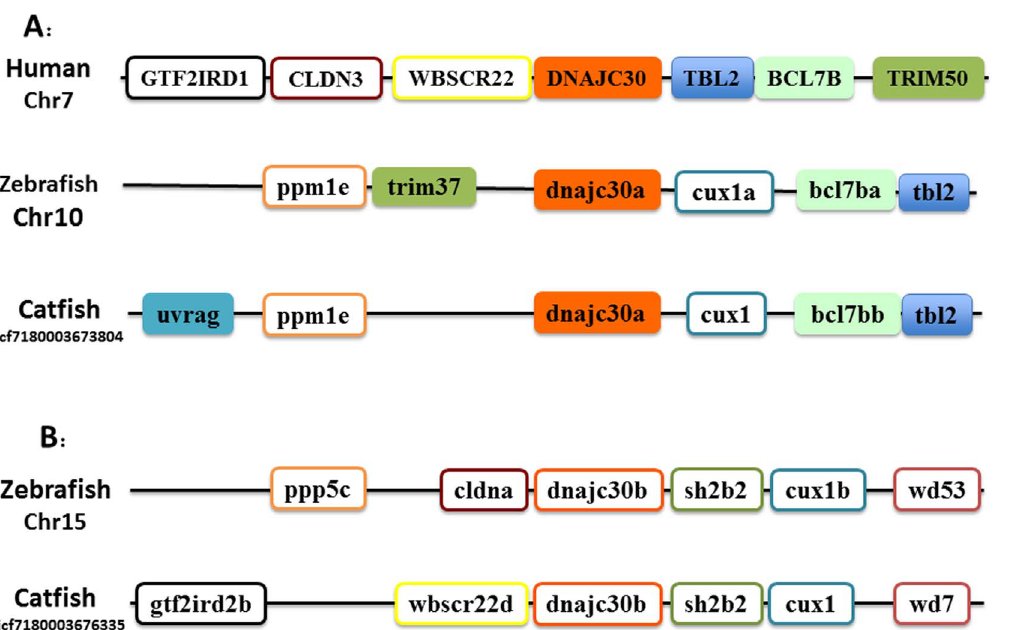
Fig. 4. Schematic presentation of the conserved synteny blocks neighboring DnaJc30a (A) and DnaJc30b gene (B). Note that in each case, the gene order and orientation was relatively conserved.Abbreviations: (A) GTF2IRD1, GTF2I repeat domain containing 1; CLDN3, claudin 3; WBSCR22, Williams Beuren syndrome chromosome region 22; DnaJc30, DnaJ (Hsp40) homolog, subfamily C, member 30; TBL2, transducin (beta)-like 2; BCL7B, B-cell CLL/ lymphoma 7B; TRIM50, tripartite motif containing 50; ppm1e, protein phosphatase 1E (PP2C domain containing); trim37, tripartite motif containing 37; cux1a, cut-like homeobox 1a; uvrag, UV radiation resistance associated. (B) ppp5c, protein phosphatase 5, catalytic subunit; cldna, claudin a; dnajc30b, DnaJ (Hsp40) homolog, subfamily C, member 30; sh2b2, fission 1 (mitochondrial outer membrane) homolog (S. cerevisiae); wd53, WD repeat domain 53; wd7, WD repeat domain 7; gtf2ird2b, GTF2I repeat domain containing